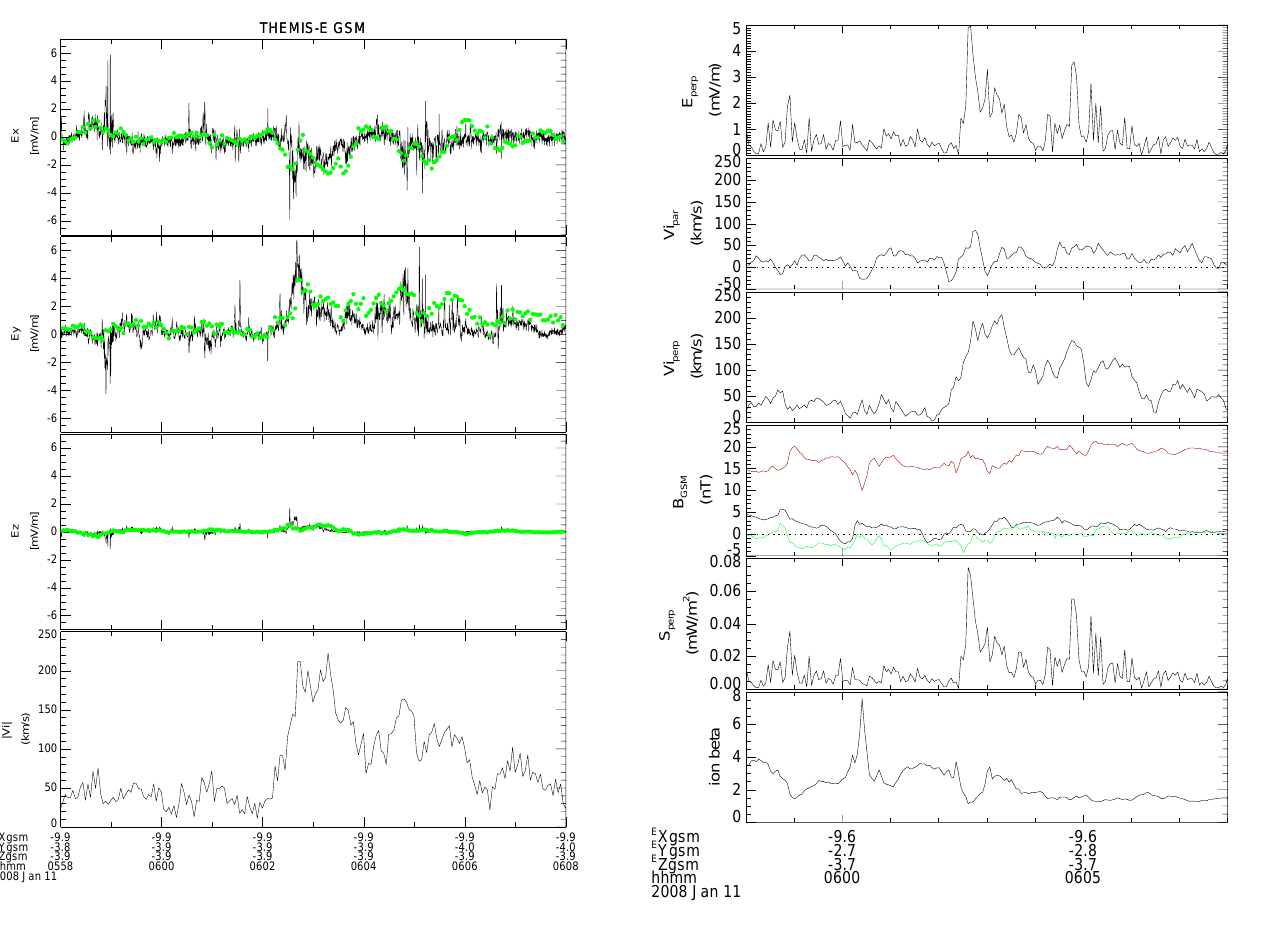
Fig. 4. Themis E observations for the same time period as in Fig. 3. The first panel displays the electric field perpendicular to the mag- netic field. The ion flows parallel and perpendicular to the magnetic field is shown in the second and third panels, respectivley. The B x (black), B y (green) and B z (red) GSM components are shown in the fourth panel. Panel five displays the perpendicular Poynting flux, while the last panel displays the ion plasma